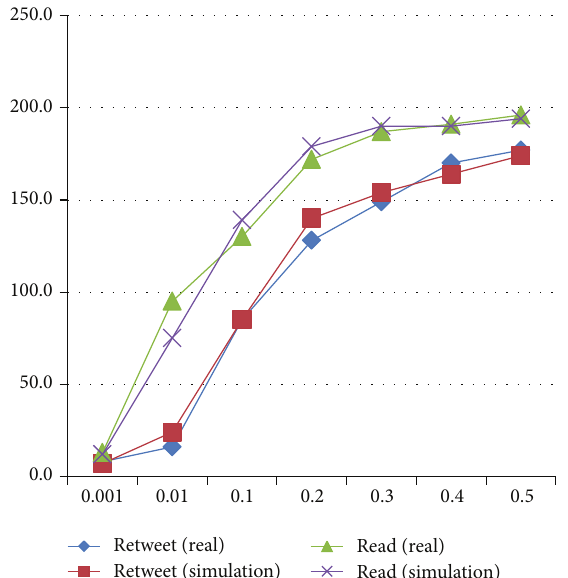
Figure 6: The relationship between the similarity of users’ interests with the release persons’ interests and knowledge propagation.